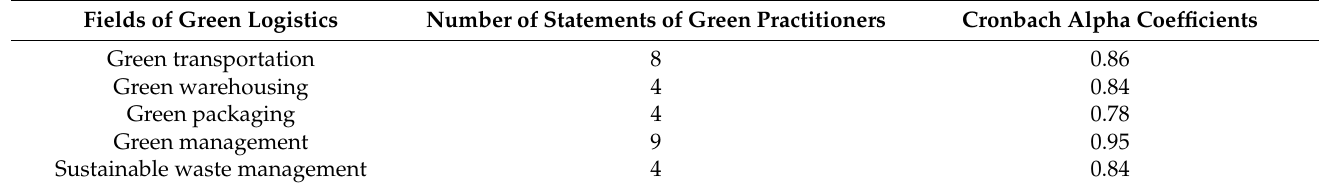
Table 1. Cronbach Alpha coefficients of reliability of the green logistic fields and practices questionnaire. Fields of Green